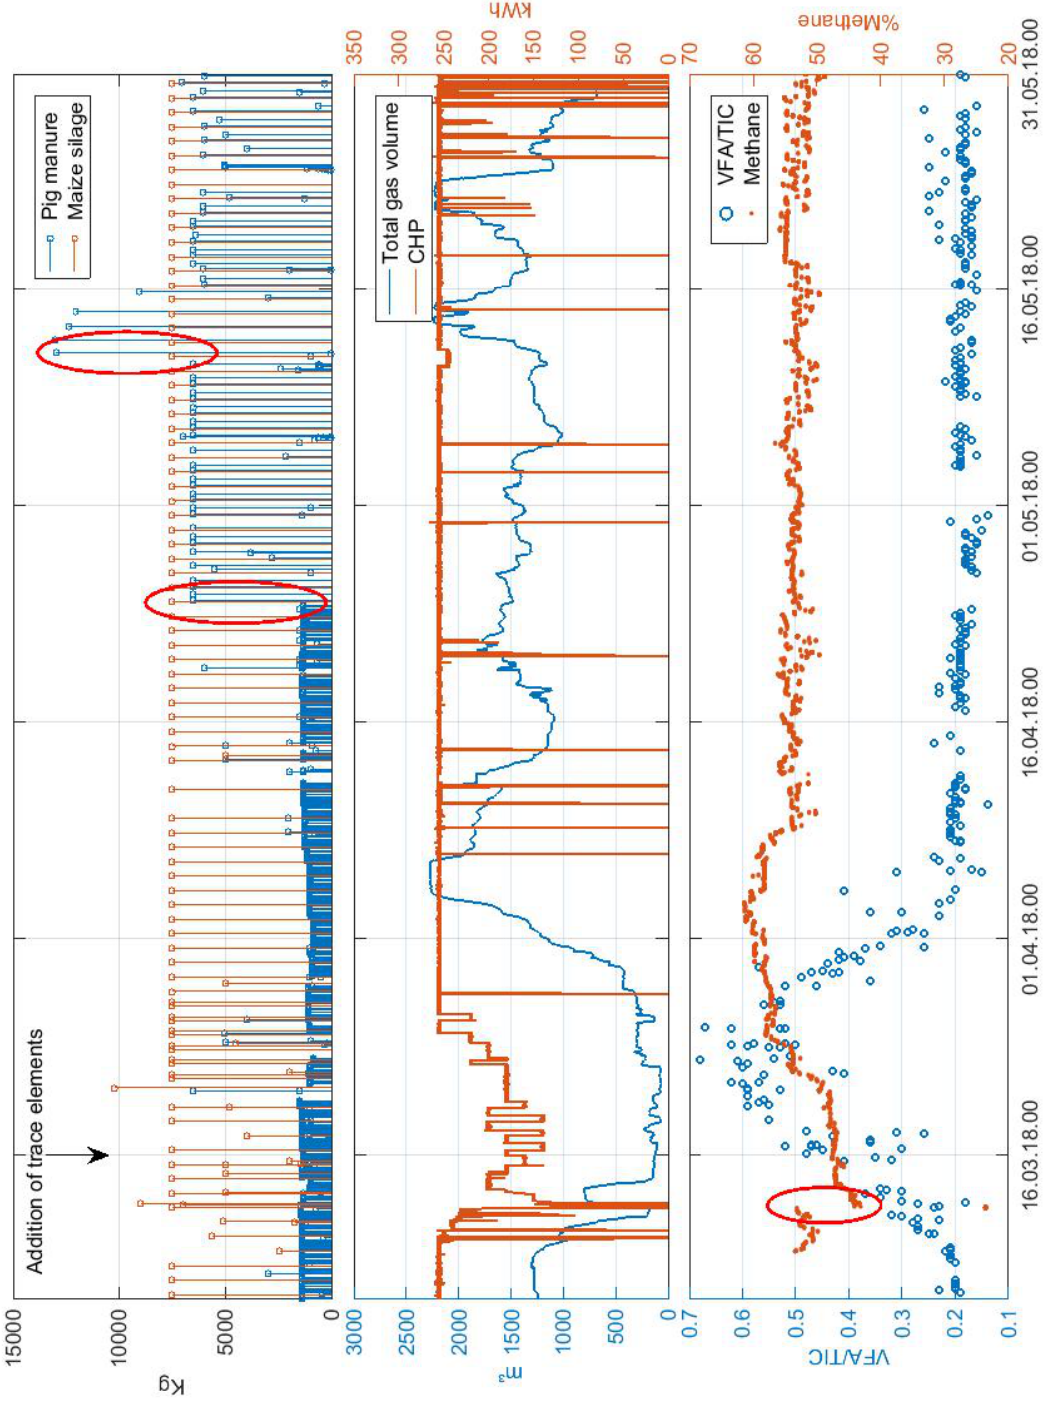
Figure 7. Three months online monitoring. On the abscissa time is given in days and on the ordinate the following aspects are given. Left: presents the digester feeding. Two feeding transition of maize silage can be identified from 1300 kg almost every 2 h to 6500 kg every 12 h and later 13,000 kg once a day. Middle: presents gas storage volume and CHP electrical generation. Generated power was reduced due to the low gas storage levels. Right: presents results of online monitoring and methane content. Process disturbance can be identified by the increase of the VFA/TIC. Calibration of the gas analyzer is marked showing a difference in the methane content from 53% to